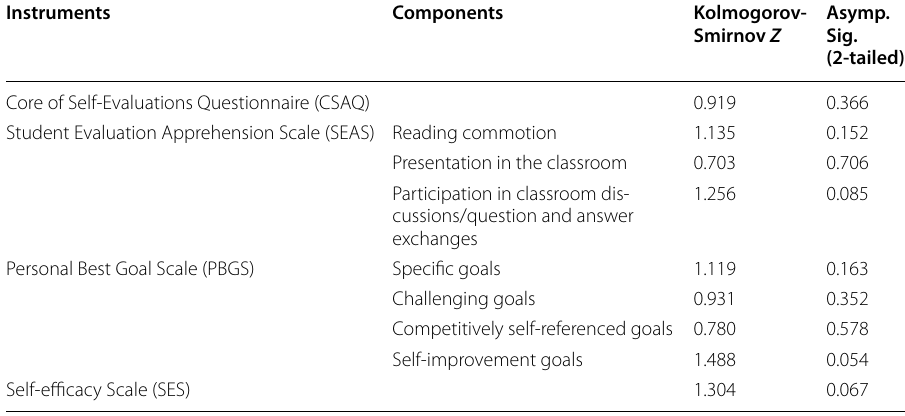
Table 2 The results of Kolmogorov-Smirnov test Instruments